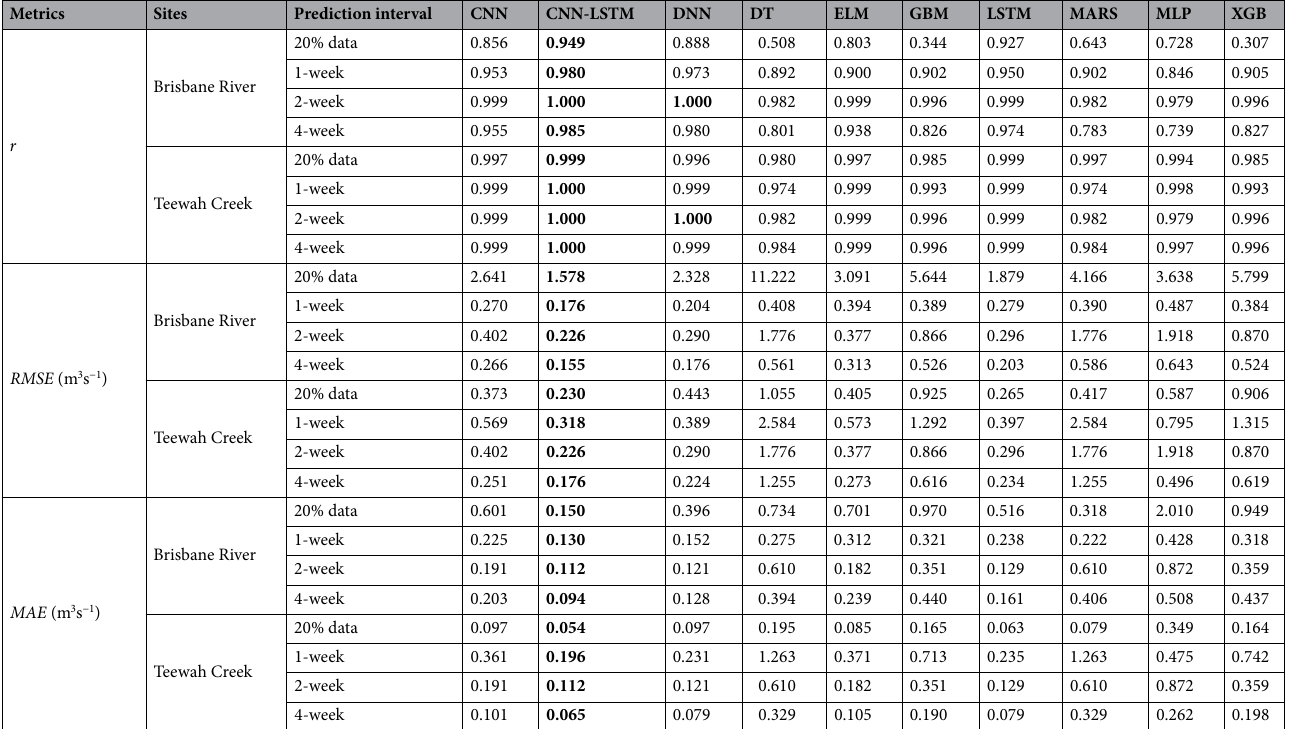
Table 4. Comparison of CNNLSTM model performances with the comparative counterpart models: Convolutional Neural Network (CNN) and Long Short Term Memory Network (LSTM) as well as the Deep Neural Network (DNN), Multi-Layer Perceptron (MLP), Extreme Learning Machine (ELM), Gradient Boosting Regression (GBM), Decision Tree(DT), Multivariate Adaptive Regression Splines (MARS) and Extreme Gradient Boosting Regression (XGB) model as measured by the correlation coefficient (r), root mean square error (RMSE; m 3 s −1 ) and mean absolute error (MAE; m 3 s −1 ) in the testing phase for hourly streamflow (Q, m 3 s −1 ) prediction. Prediction was done for 1-hour horizon for 20% of total data(9-Months), 1-Week (1W), 2-Week (2W) and 4-Week (4W) Best Model is highlighted in